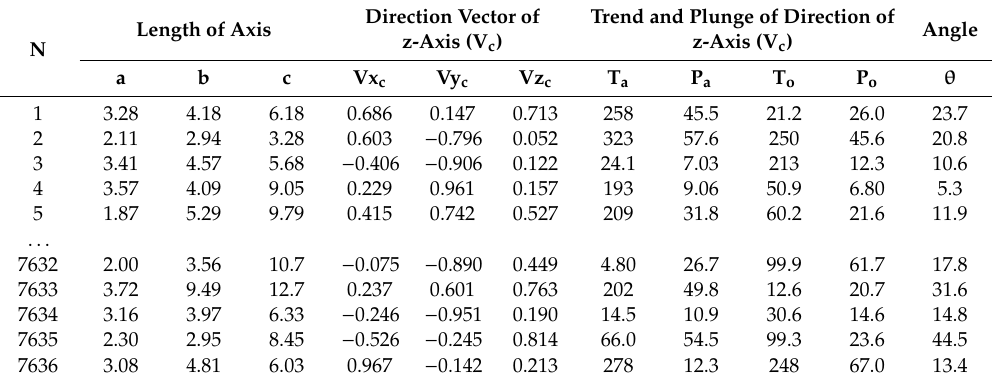
Table 1. Measurement examples after ellipsoid fitting for 3D µ -CT images of the fault gouge sample. Direction Vector of Trend and Plunge of Direction of Length of Axis z-Axis (V c ) z-Axis (V c ) N